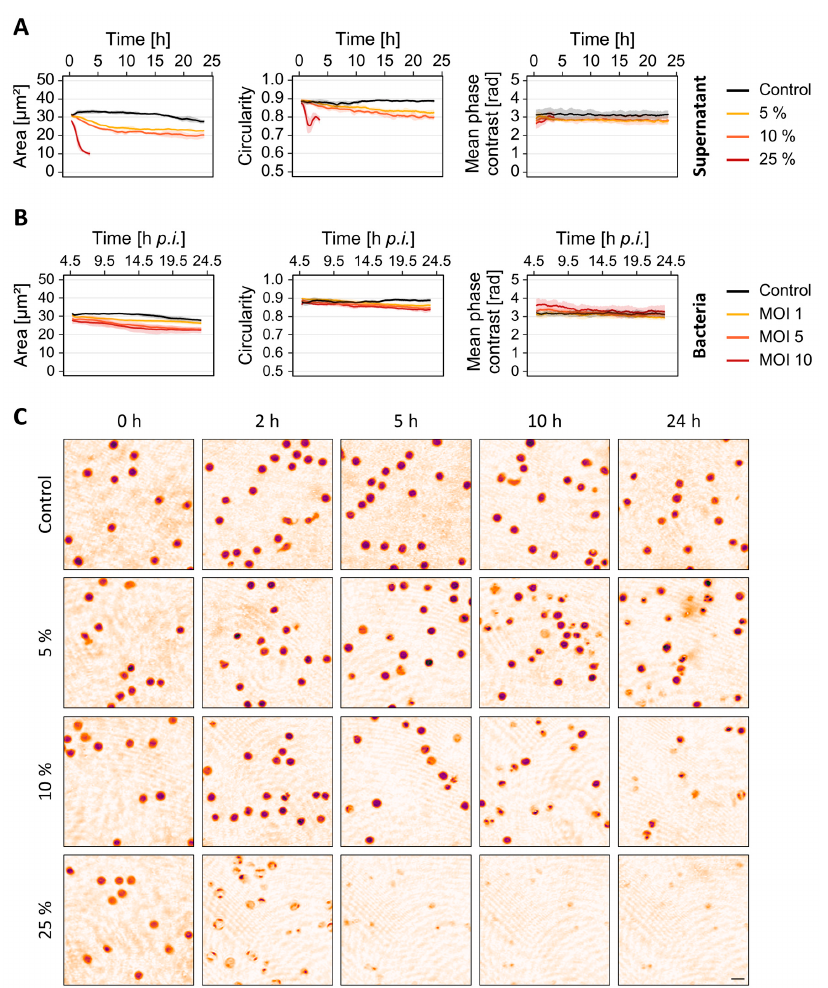
Figure 4. Concentration-dependent effect of bacterial culture supernatant and living bacteria on T-cell morphology. ( A ) Human primary T-cells were exposed to different concentrations of S. aureus 6850 culture supernatant. ( B ) T-cells were infected with different bacterial loads of S. aureus 6850. Timelapse DHM was started 5 h after the addition of bacteria. ( A , B ) Quantitative phase contrast images were analyzed for average single cell area, average circularity and mean phase contrast per cell. Results are presented as mean (solid lines) ± SD (shading) of at least three independent mea- surements. The graphs were smoothed using moving averages with a window size of 15 measuring points. ( C ) Representative pseudo-colored phase contrast images of T-cells treated with S. aureus 6850 supernatant at indicated measurement time points. The scale bar corresponds to 10 µ